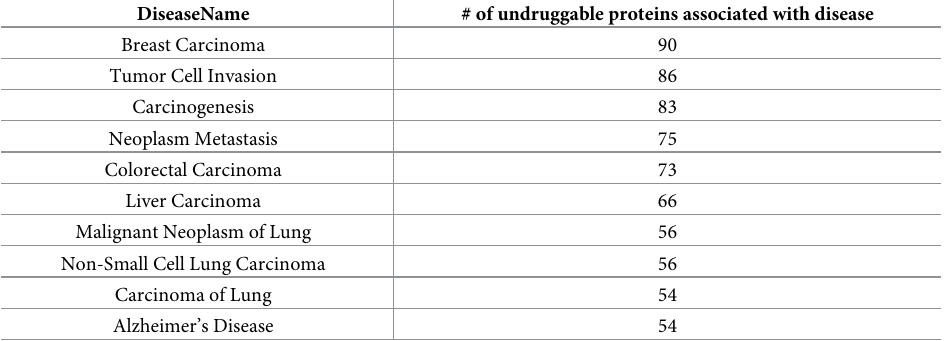
Table 5. These highly-ranked diseases are associated with undruggable human disease proteins, as selected by